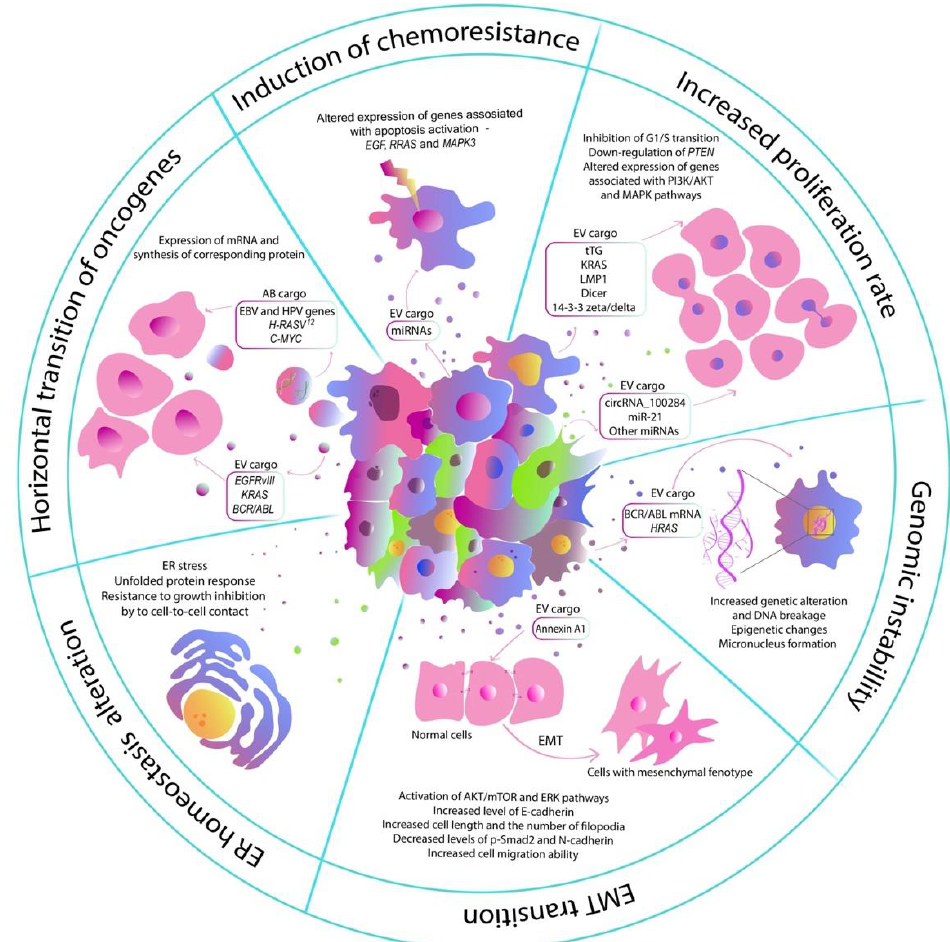
Figure 1. The influence of tumor-cell-derived extracellular vesicle on the metabolism, structure, and epigenetic profile of normal cells. epigenetic profile of normal